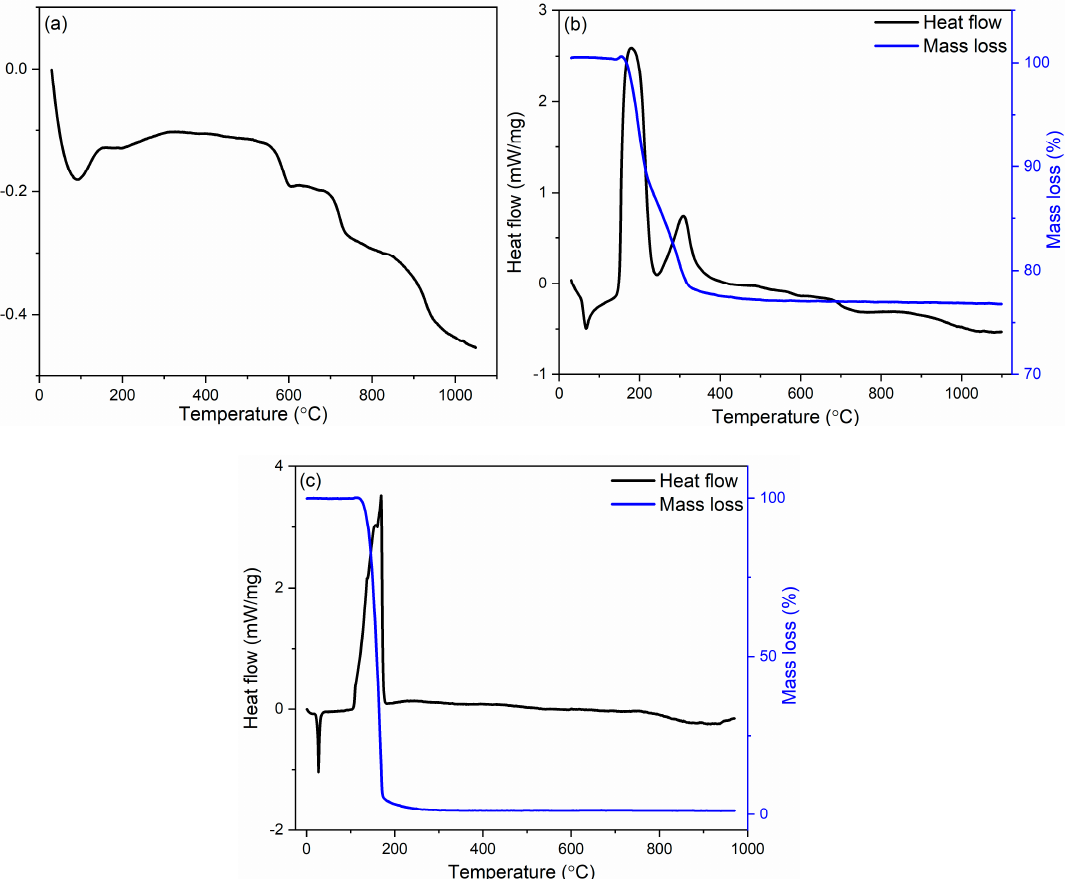
Figure 7. Differential scanning calorimetry coupled with thermogravimetry (DSC/TG) curves of Figure 7. Di ff erential scanning calorimetry coupled with thermogravimetry (DSC / TG) curves of borosilicate glass ( a ), printed sample ( b ), and pure Pluronic F-127 ( c ). borosilicate glass ( a ), printed sample ( b ), and pure Pluronic F-127 ( c